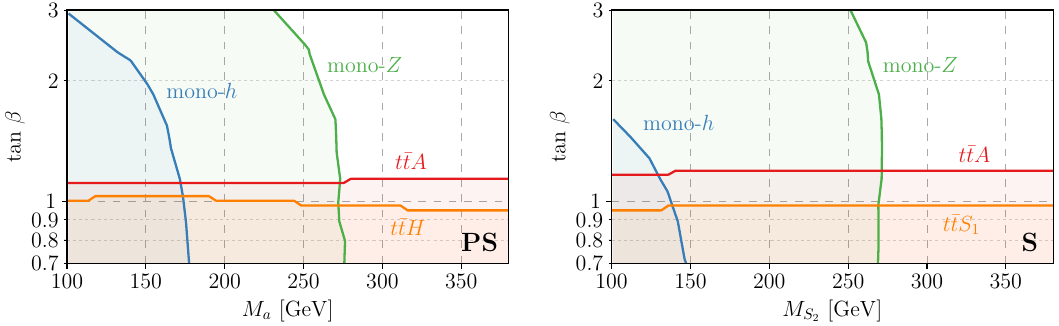
Figure 14 . Overview on the 2 (cid:27) exclusion limits from mono- h , mono- Z , t (cid:22) t resonance (for scalar and pseudoscalar mediator) and Higgs to invisible searches (see text for details) in the M plane for the 2HDM+PS (left) and 2HDM+S (right). In both plots we use the parameters as given in eq. (4.4) and M = M = M A = 500 H=S 1 H (cid:6)